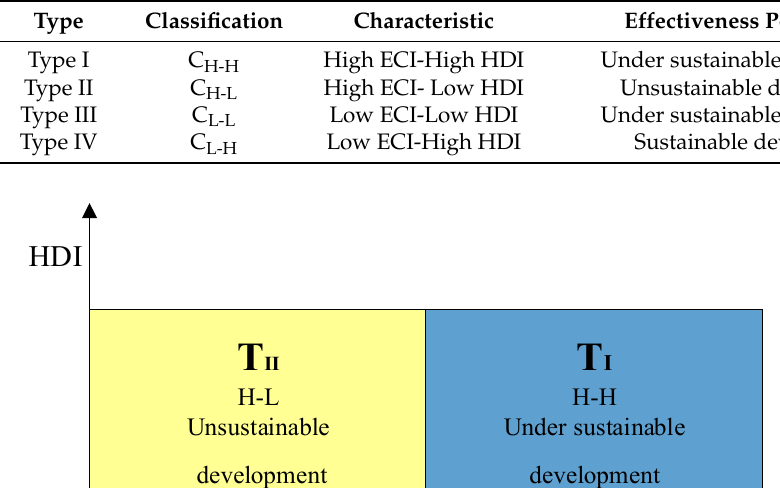
(17) Table 4. The index benchmark of Human Development Index (HDI). Index (Unit)